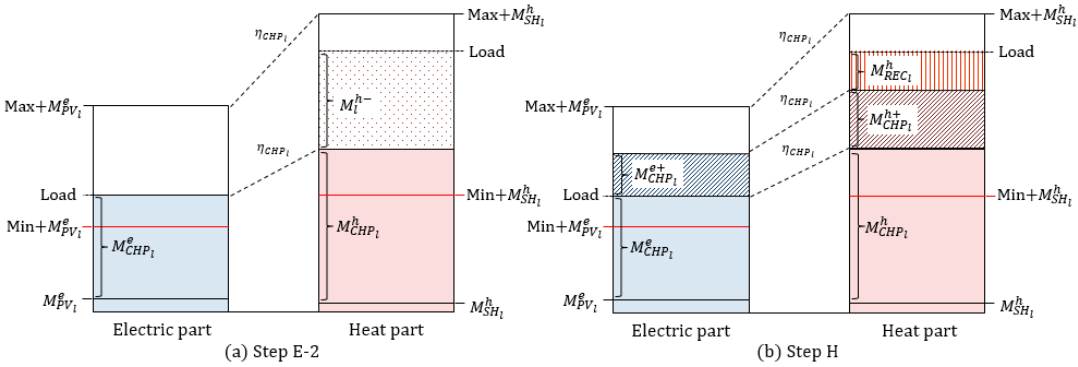
Figure B1. Example ‐ 1 when ∑ Figure B1. Example-1 when